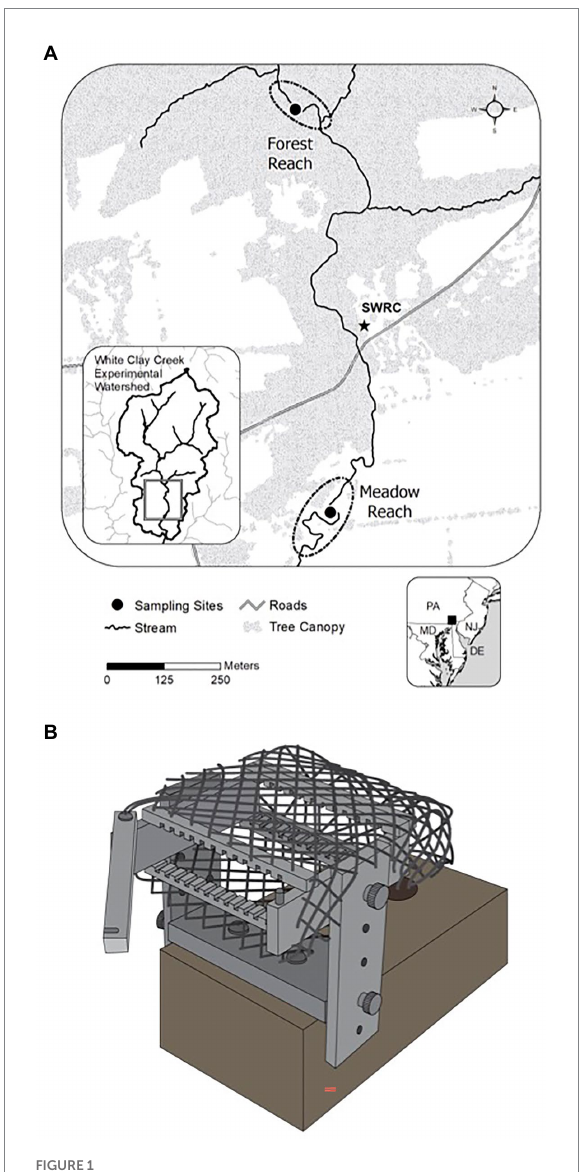
FIGURE 1 Map of the experimental locations at White Clay Creek (A) and a schematic design of a periphytometer (B)